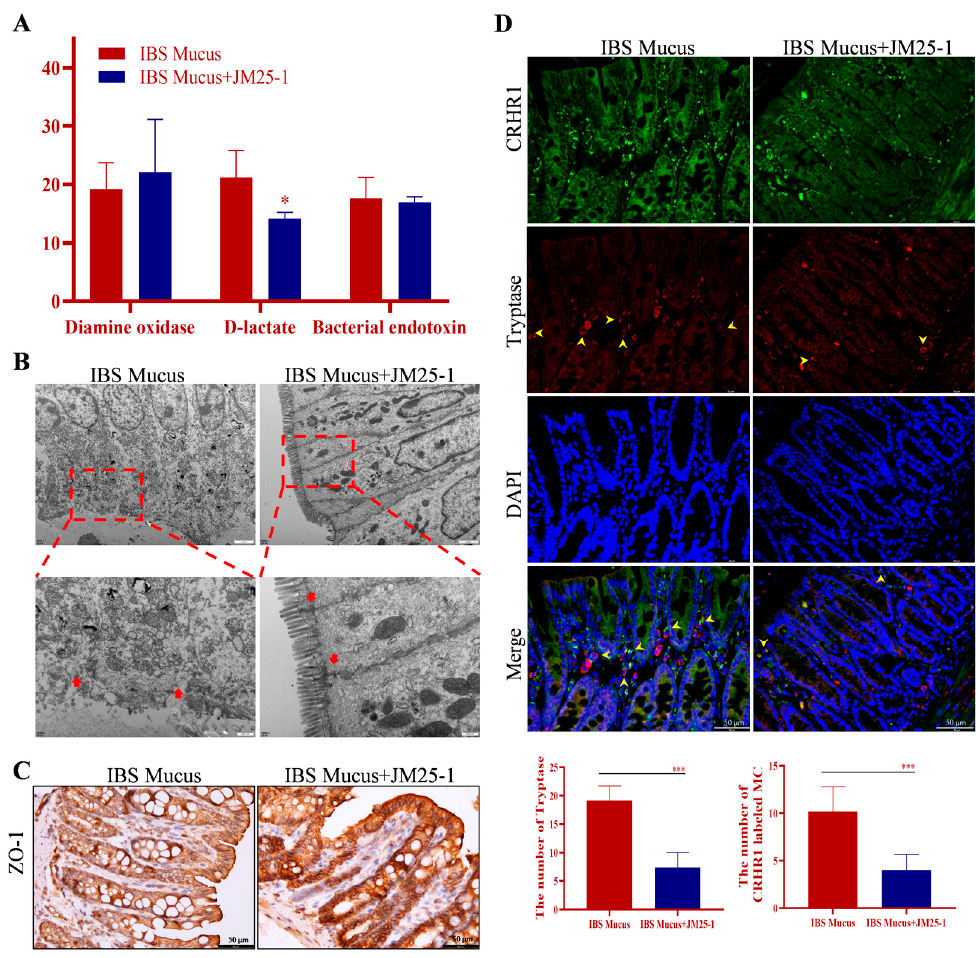
Figure 8. JM25-1 regulated intestinal barrier defect in IBS intestinal mucus transplantation rats. ( A ) The level of diamine oxidase, D-lactic acid and bacterial endotoxin in serum. bars, S.D. * p ≤ 0.05. ( B ) Transmission electron microscope images of colonic segments. Magnification: 8000×. Scale bar: 2 μ m. Magnification: 25,000×. Scale bar: 500 nm. ( C ) The immunohistochemistry staining of ZO-1 in the colon. ( D ) The immunofluorescence staining of CRHR1-labeled Tryptase. Magnification: 400×. Scale bar: 50 μ m. Bar chart indicates the number of Tryptase and CRHR1 labeled MC; bars, S.D. *** p ≤ 0.001.